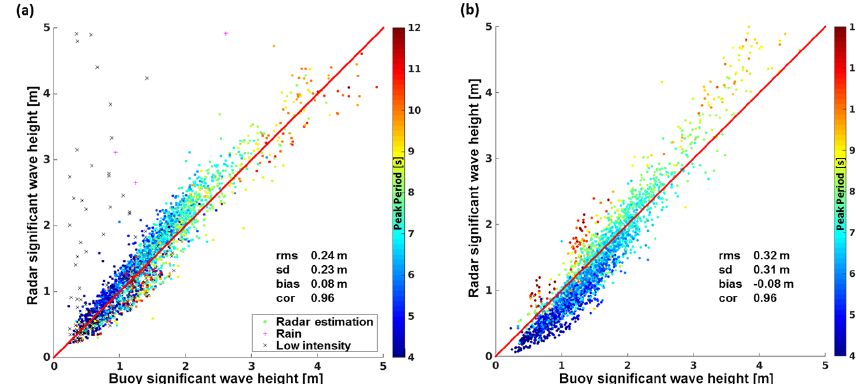
Figure 7. Scatter plot of significant wave height from buoy data versus the significant wave height from the radar-retrieved Doppler velocities using (a) H s = 4 σ D and (b) H s = 4 · 082 u DRMS /ω p . Color coding gives the peak period resulting from the buoy data. A black x marks all radar data with very low radar backscatter, while the cases marked by a pink + are data which were recorded in very heavy rain. The statistics of the comparison, shown on the lower right, were retrieved excluding the cases with a low radar backscatter or which were acquired in heavy rain.